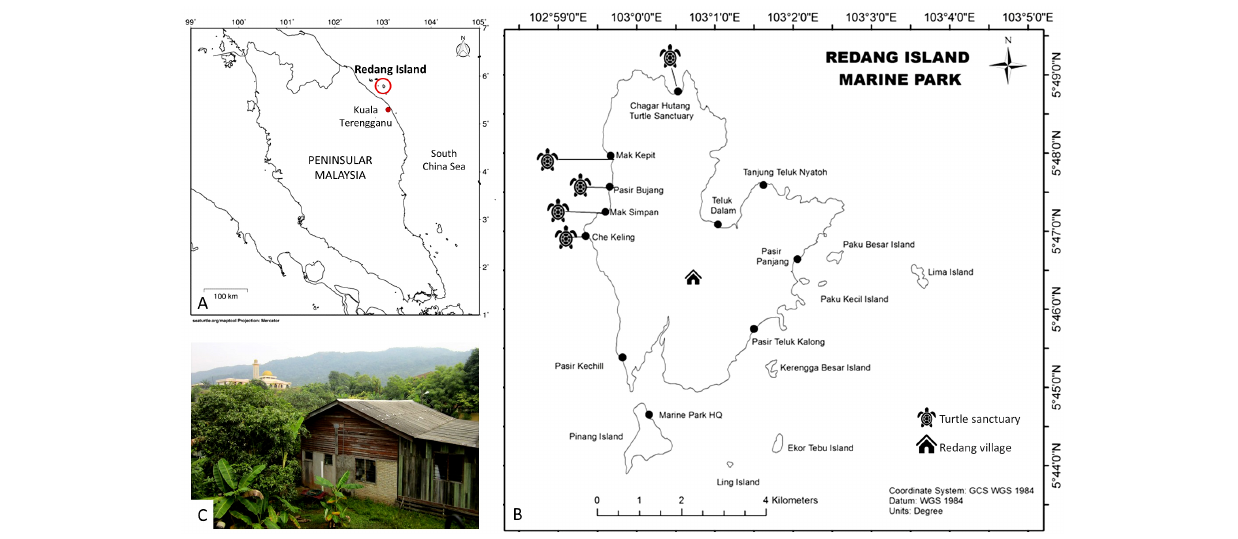
Fig. 2 . Location of the study site: (A) Map of Peninsular Malaysia indicating the location of Redang Island. (B) Map of Redang Island Marine Park indicating the turtle sanctuaries on the west and north of the island and the village in the center. Most resorts are located at the Pasir Panjang beach on the east side of the island. (C) Sampling was conducted in Redang village, the only settlement in the island. The village is located in the center, with no direct access to the turtle nesting beaches. Map adapted from Chan